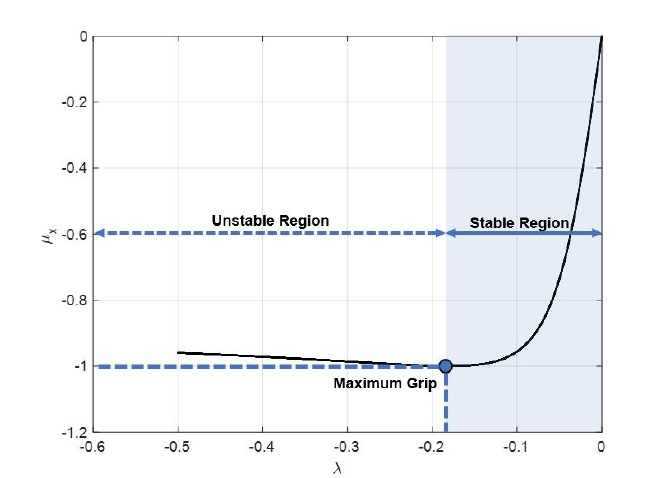
Figure 3. Tire characteristics curve and potential friction coefficient.